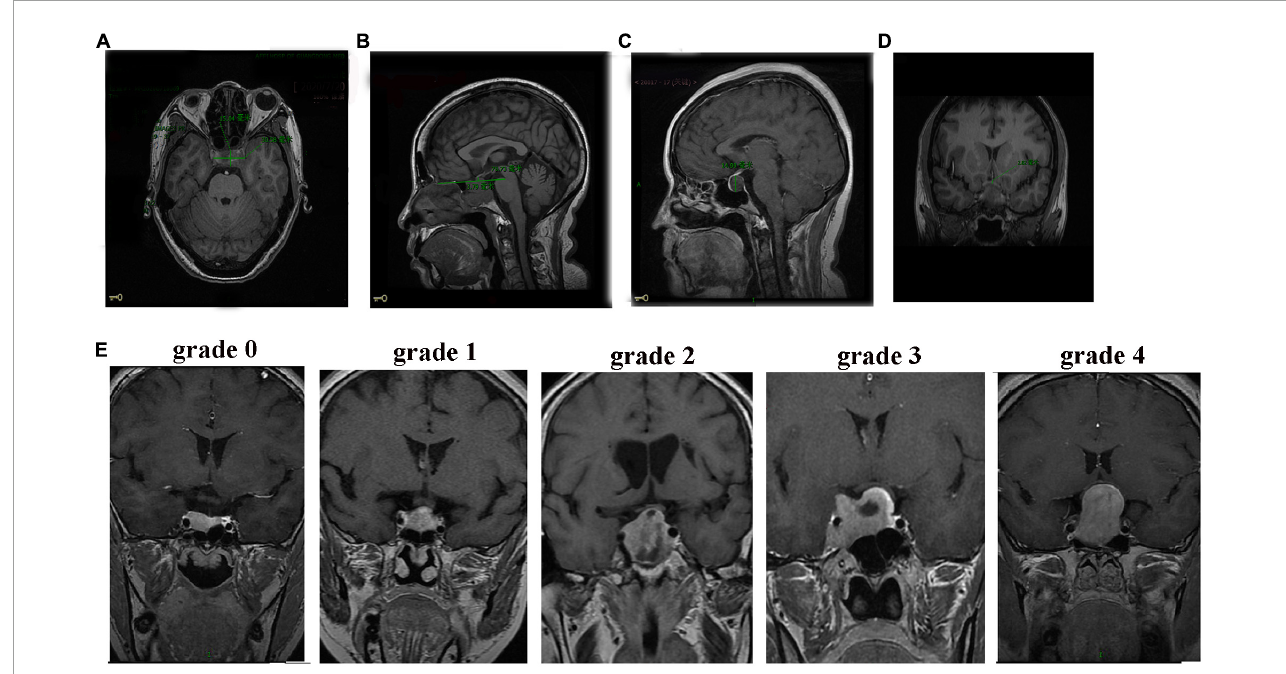
FIGURE1 MRI images of patients with NFPA. (A) Axial position measurement of the horizontal diameter line (30.58 mm) and the anteroposterior diameter line (15.04 mm). (B) Sagittal measurements of the epitaxial height of the sella turcica diameter line (3.79 mm). (C) Sagittal measurements of the vertical diameter line (14.99 mm). (D) Thickness measurement of the optic chiasm. (E) Grades (0–4) of tumor compression on the optic